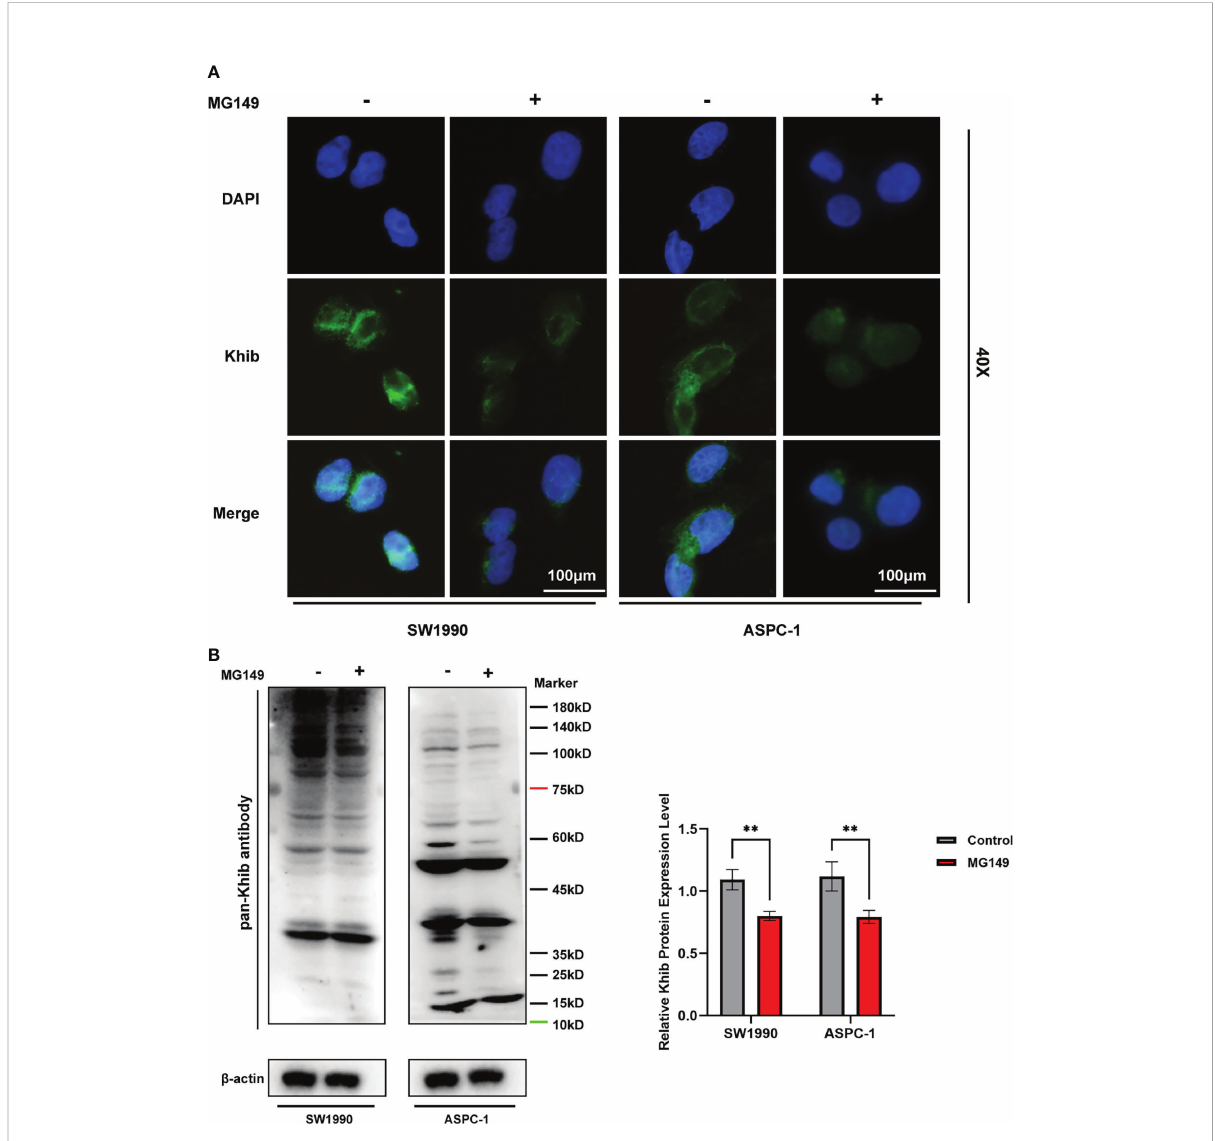
FIGURE 6 The total 2-hydroxyisobutyrylation (K hib ) level in pancreatic cancer (PC) cells were suppressed by MG149. The SW1990 and ASPC-1 cells were treated with MG149 (74 m M), and then the immuno fl uorescence and Western blot assays were performed with pan-K hib antibody. (A) Immuno fl uorescence assay for PC cells treated with MG149. Different stains represent speci fi c target genes, K Scale bar, 100 m m. (B) Western blotting analysis of the K hib proteins in the SW1990 and ASPC-1 cells treated with MG149. ** P <0.01, determined by independent Student ’ s t tests. Data are derived from three independent experiments and presented as